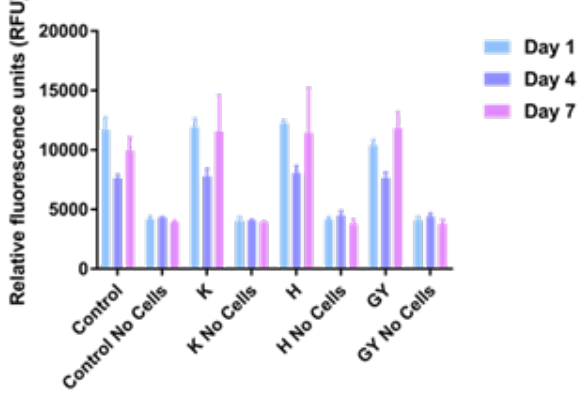
Figure 3. Proliferation assay of MG63 cells on Ti6Al4V samples after 1, 4, and 7 days. Error bars indicate standard deviation. Control: tissue culture polystyrene; H: collagen + HE800 derivative; K: bare Ti6Al4V; EY: collagen + GY875 derivative.